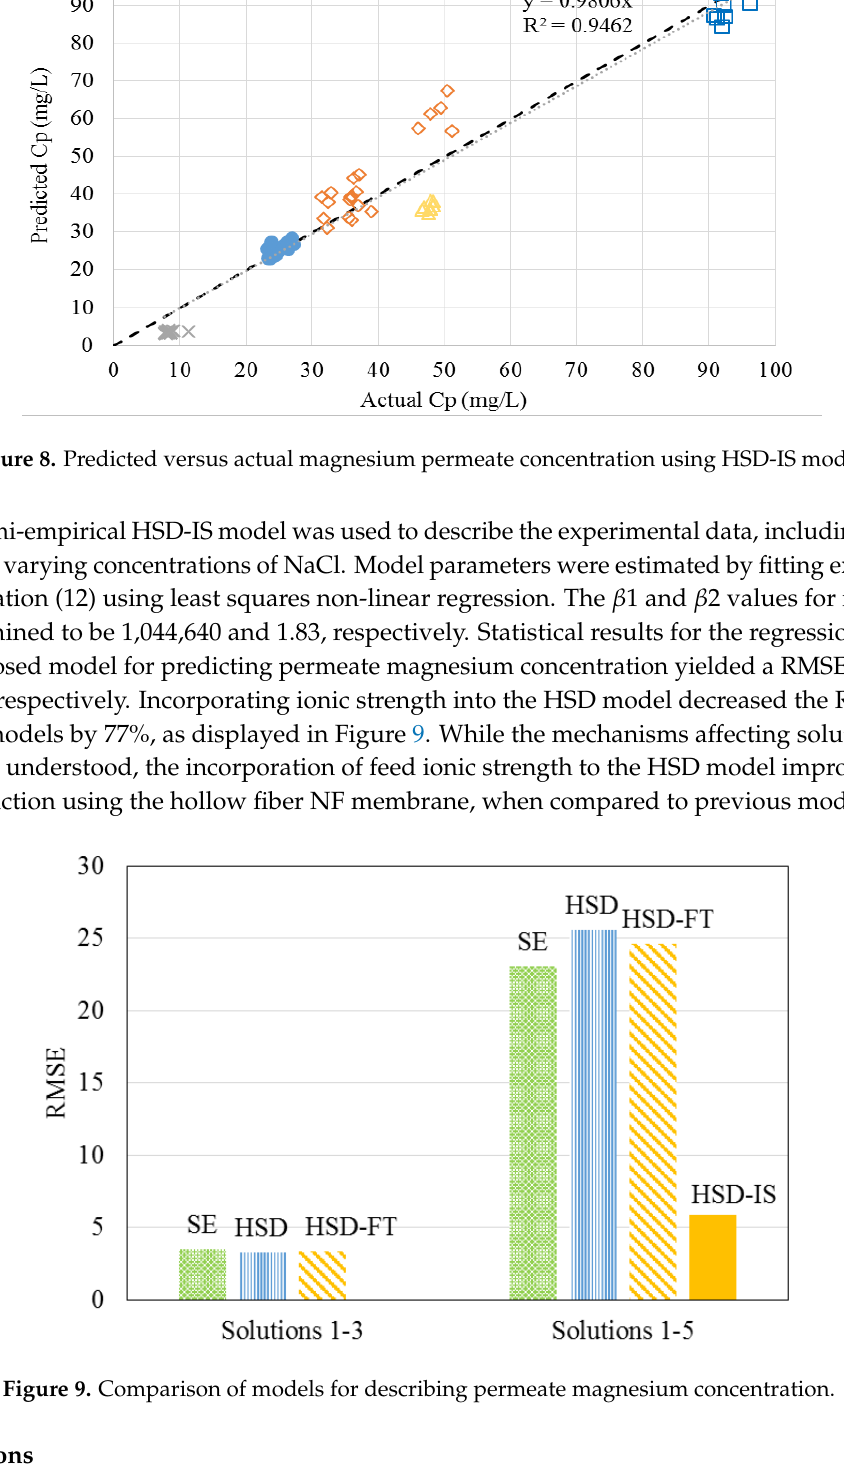
Figure 7. Predicted versus actual magnesium permeate concentrations using homogeneous solution diffusion (HSD) model.